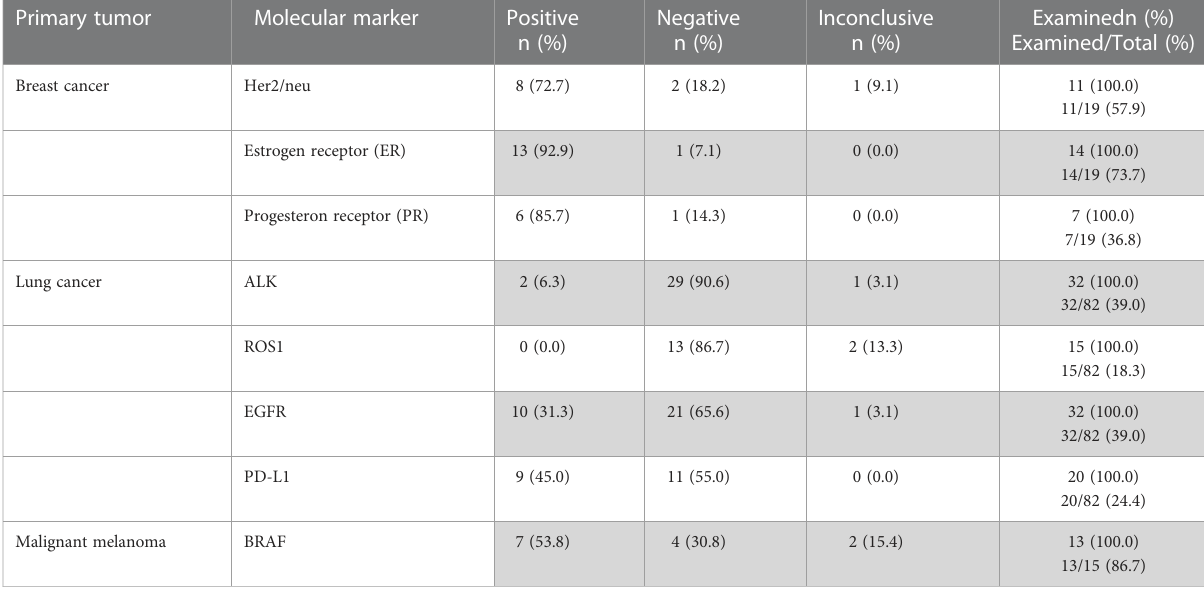
TABLE 4 Molecular markers analysed among different tumor entities.